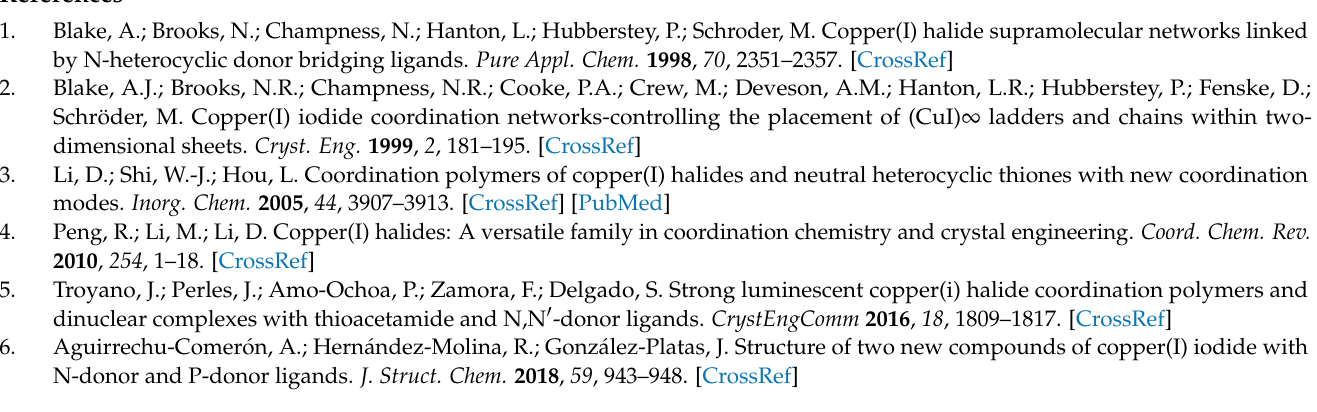
temperature; Table S2: Crystal data and structure refinements for (CuI) 2 -Quin sample at different pressures (0.00–7.00GPa) at room